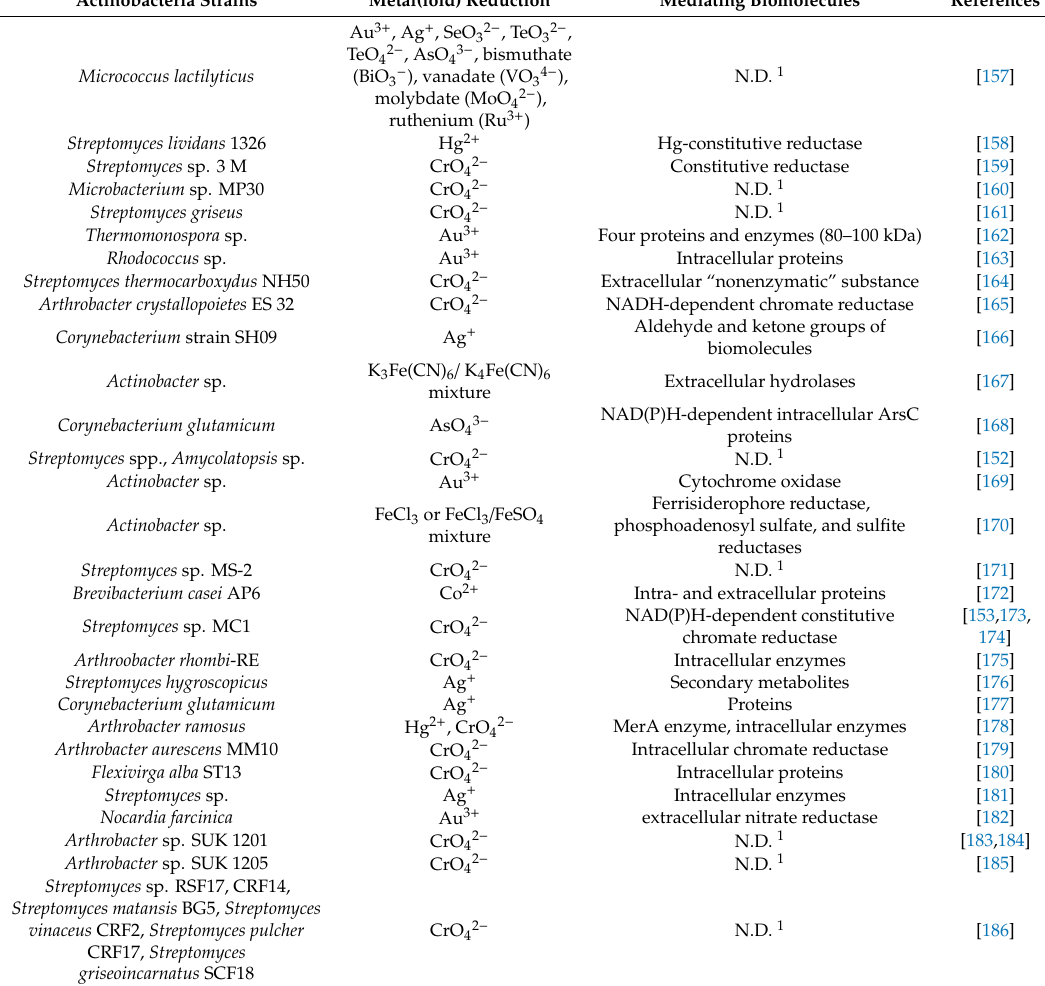
Table 3. Overview of metal(loid) reduction processes in